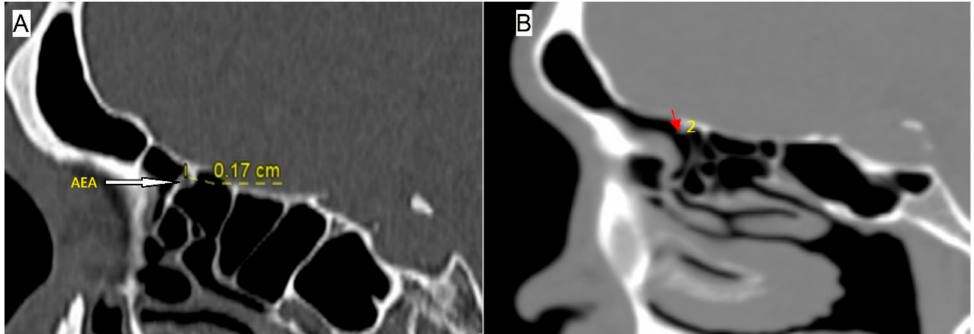
Figure 4. Location of anterior ethmoidal artery (white arrow) at the second lamella ( A ). The distance of anterior ethmoidal artery from the skull base is measured in a vertical line, and 6.2% of anterior ethmoidal artery (red arrow) was identified between the first and second lamellae (2) ( B